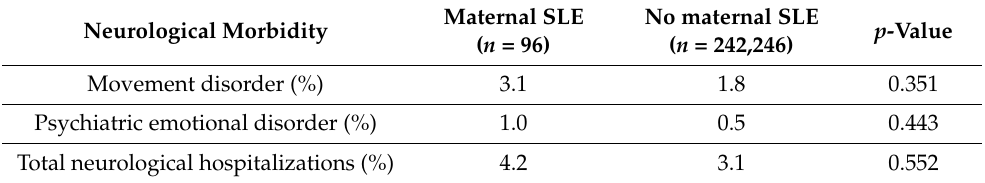
Table 4. Selected long-term neurological morbidity in offspring of women with and without SLE. Neurological